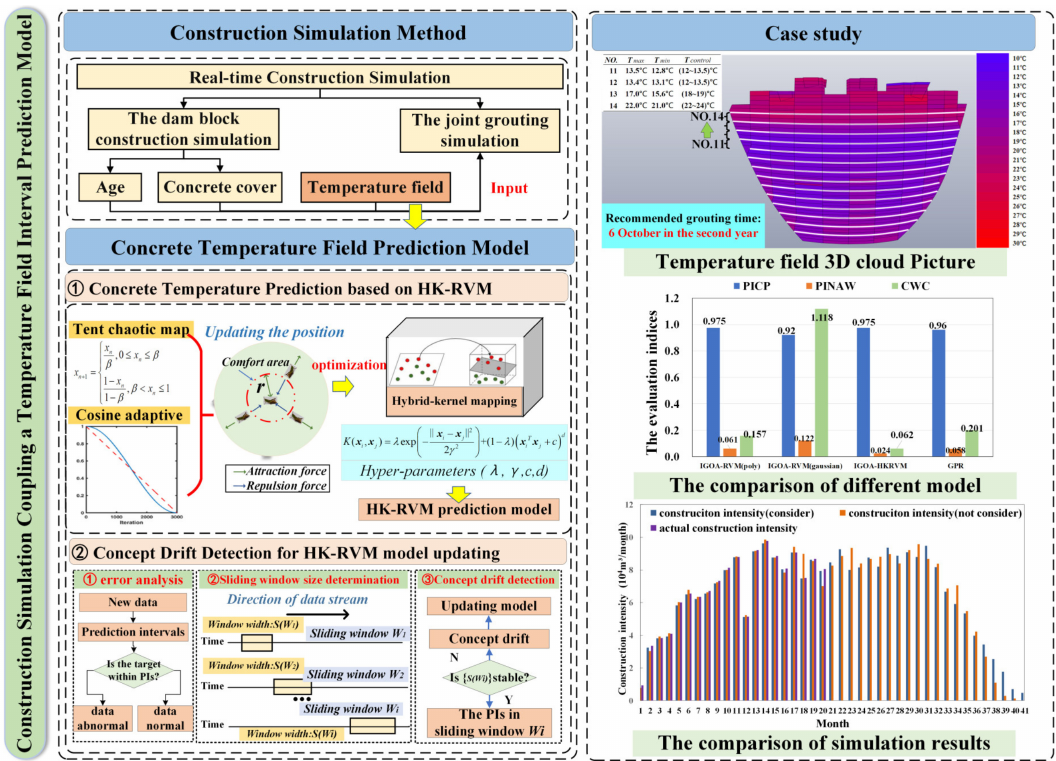
Figure 1. Research